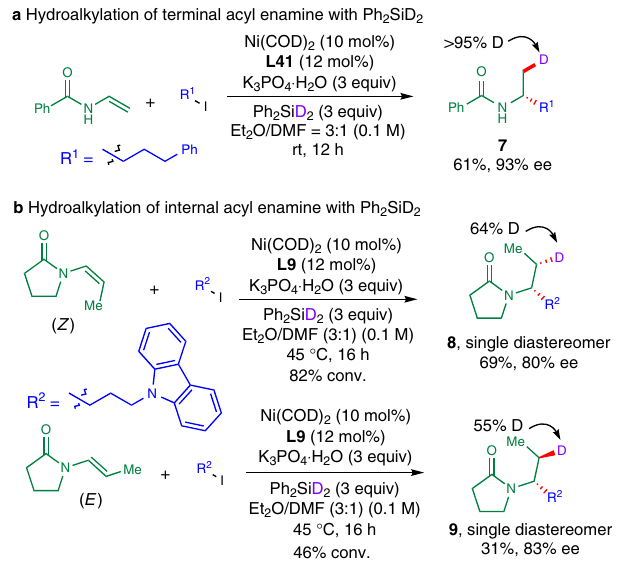
Fig. 6 Mechanistic probe for the reaction. a Hydroalkylation of terminal acyl enamine with Ph 2 SiD 2 . b Hydroalkylation of internal acyl enamine with Ph 2 SiD 2 . NATURE COMMUNICATIONS| (2021) 12:2771